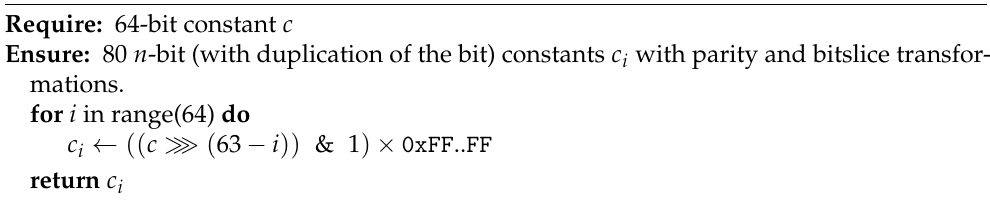
Algorithm 6 Constant c bitsliced and